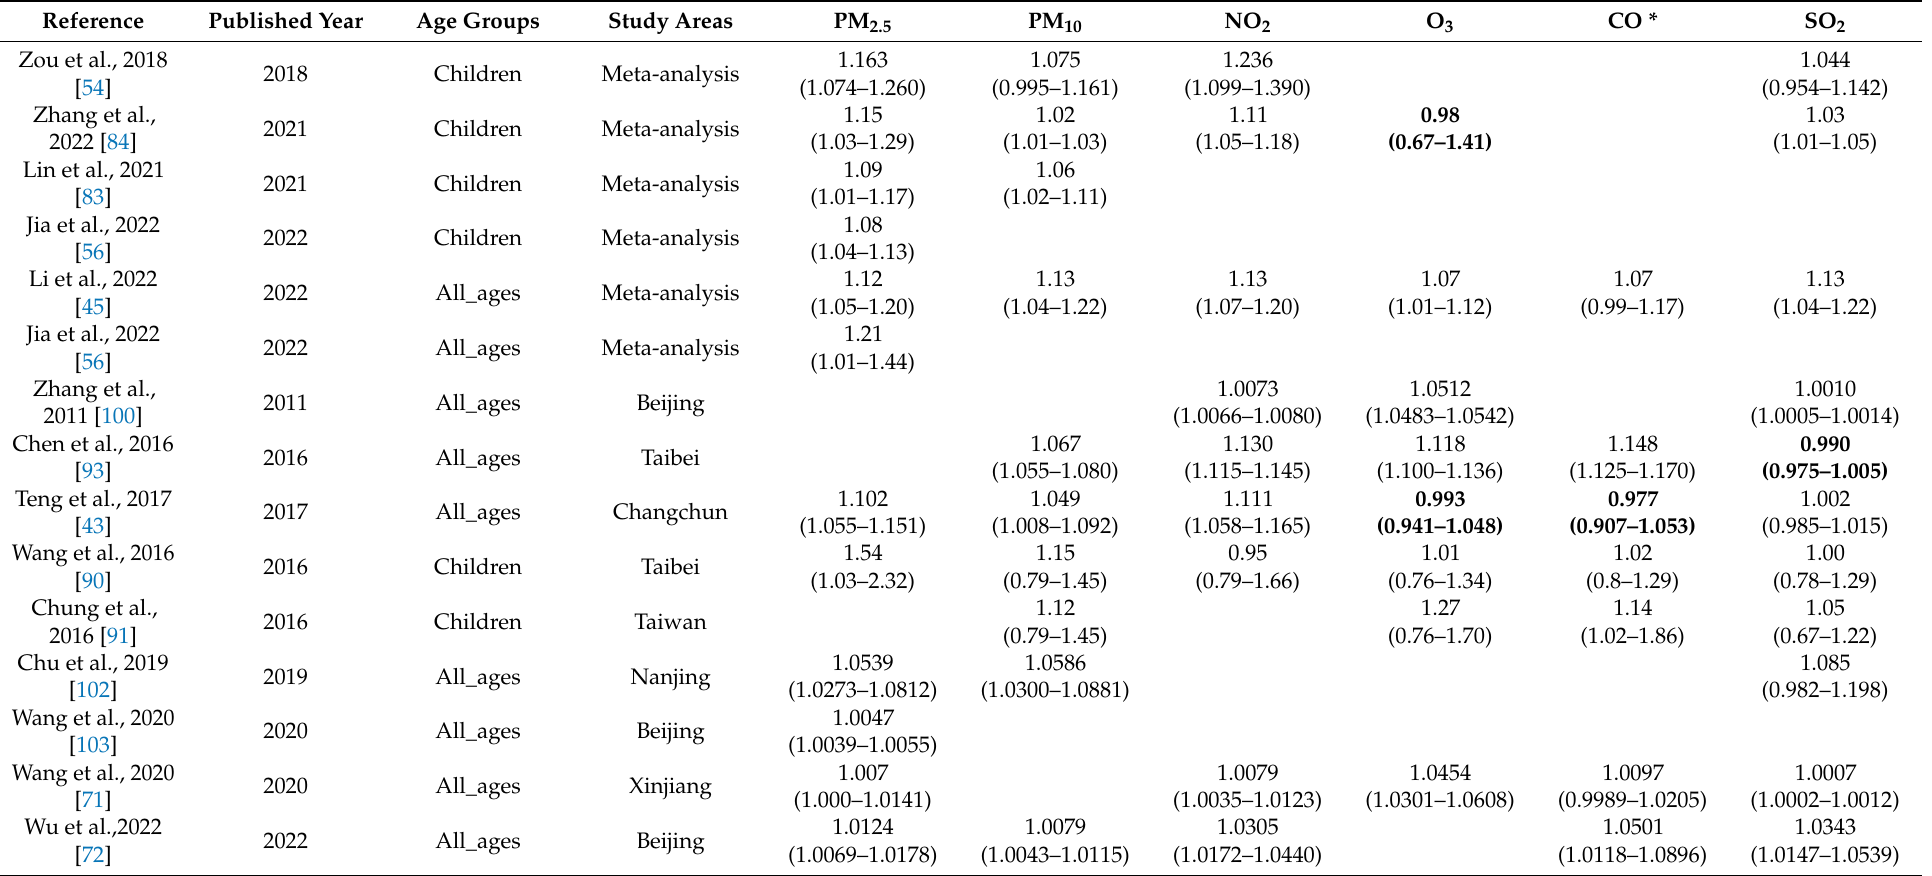
Table 3. The compiled relative risks of exposure to various ambient pollutants with a 10 µ g/m 3 increase in single case studies and meta-analysis